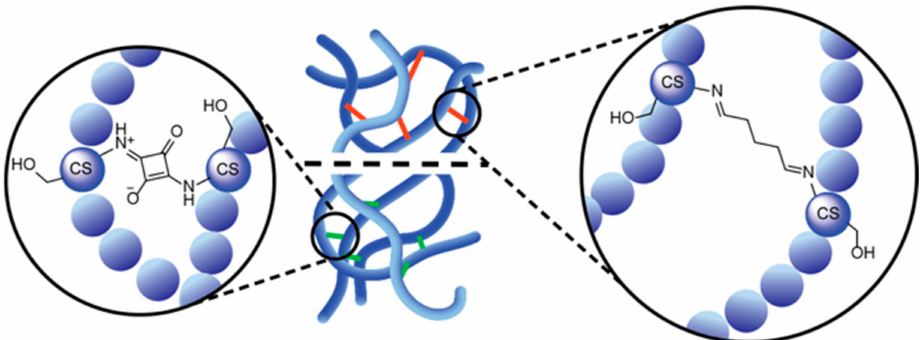
Figure 6. Cross-linking of CS chains with Glu (right circle) and squaric acid (left circle). For visibility, the CS units not involved in the interaction are represented by a simple blue